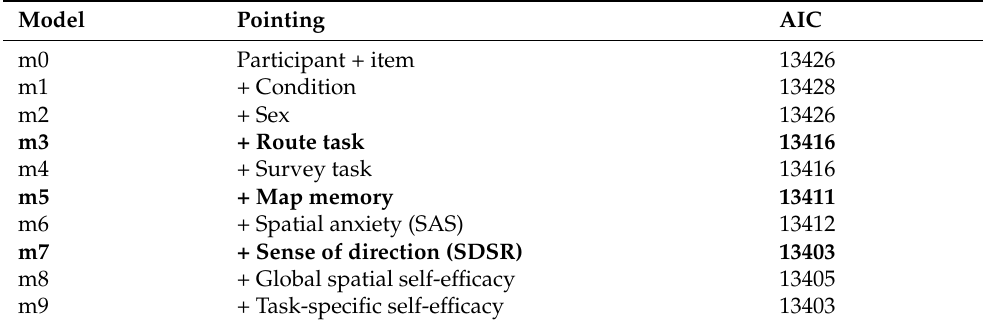
Table 3. Pointing: stepwise model selection results. Variables that decreased AIC appear in bold.